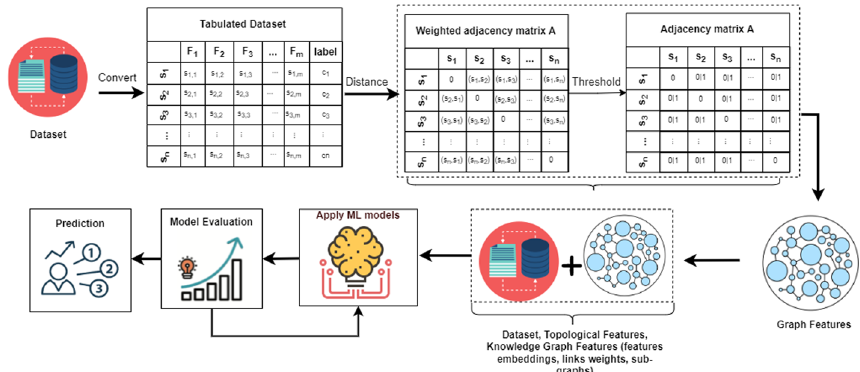
Fig. 1 Overview of the suggested knowledge graph